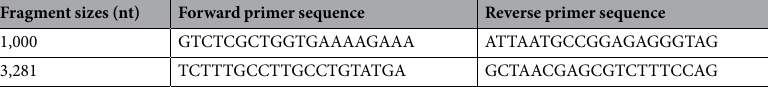
Polymerase enzyme characterization for ssDNA production. To evaluate reaction conditions for the synthesis of long ssDNA, two sets of validated aPCR primers and M13 genomic ssDNA as a template were used to generate products of sizes 1,000 nt and 3,281 nt (Table 1) 11 . The following enzymes were purchased from the respective commercial providers to test enzymatic produc- tion of ssDNA: AccuStart ™ , AccuStart ™ II, and AccuStart ™ HiFi from Quantabio; Q5 ® hot start HiFi, Phusion ® , LongAmp ® , Deep Vent ® , and Deep Vent ® (exo-) from New England BioLabs Inc. (NEB); AccuPrime ™ , Platinum ™ SuperFi ™ , Tth and DreamTaq ™ from ThermoFisher Scientific Inc.; GoTaq ® from Promega (Promega corp.); and LA Taq ® from Takara Bio. These were characterized for their aPCR efficiency, yield, and off-target production metrics for the quality of aPCR. Each enzyme was evaluated using the supplier’s recommended pro- tocol for traditional PCR, including supplied buffers (Supplementary Table S1), with the exception that the for- ward primer was used in 50-fold excess over the reverse primer. Annealing temperatures were evaluated at 55 °C and reactions were thermocycled 30 times. Products were run on a 0.7–1% low-melt agarose gel (IBI Scientific, Inc.) cast with ethidium bromide (Sigma Aldrich, Inc.) or SybrSafe (ThermoFisher Scientific, Inc.) at 90 V for 1–2 hours, depending on fragment size, and visualized under blue or UV light illumination. Equal reaction vol- umes were used in each lane. Band intensities were analyzed with ImageJ Gel Analyzer 31,32 for comparison. Reagent evaluation. Systematic evaluation of the aPCR reaction included characterizing the impact of magnesium concentration, bottom-strand concentration, template concentration, cycle number, and annealing temperature. For AccuStart HiFi reactions, the standard aPCR reaction was set using 1x AccuStart HiFi buffer (60 mM Tris-SO double stranded gBlock from Integrated DNA Technologies, Gibson assembled dsDNA 33 , or Phusion generated and purified double stranded DNA template), brought to 50 µ L with nuclease-free water (IDT), with 0.22 µ L AccuStart HiFi enzyme added to begin synthesis. Thermocycled reactions were initiated for 1 min at 94 °C, and thereafter cycled 30 times for 20 s at 94 °C, 30 s at 55 °C, and 90 s per kilobase at 68 °C. Variations in cycling param- eters were performed about this reaction, with 20 µ L reactions combined with 4 µ L 6x loading buffer ran on 1% low-melt agarose cast with 1x SybrSafe and ran for 1 hour at 90 V. Gels were visualized with a blue-light illumina- tion and band intensities were quantitated by integration using ImageJ 31,32 . LongAmp reactions were similar in setup to the AccuStart HiFi. The standard reaction was in 1x LongAmp buffer (60 mM Tris-SO phage genomic DNA) and 2 µ L LongAmp Taq DNA polymerase mix and brought to 50 µ L. Thermocycled reac- tions were initiated for 30 s at 94 °C and cycled 30 times for 20 s at 94 °C, 45 s at 56.5 °C, and 90 s per kilobase at 65 °C. Parameter optimization was carried out by varying this general reaction. Samples were run on a 0.8% low-melt agarose gel stained with either ethidium bromide or SybrSafe for 1–1.5 hours at 100 V. Gels were visual- ized with UV or blue light and band densities were quantified by integration with ImageJ 31,32 . Titrations of reaction component concentrations including magnesium, template, and reverse primer concen- trations, and varying the number of cycles were carried out for both HiFi and LongAmp reactions for 1,000 nt and 3,281 nt ssDNA products. Reaction conditions and associated band intensities are presented in External Table 1. Purified ssDNA quantitated by UV absorbance at 260 nm wavelength was titrated on an agarose gel, and band intensities were measured using ImageJ to generate a standard intensity curve, which was then used to quantitate ssDNA production from a triplicate of aPCR reactions. ssDNA purification. volumes) of the provided binding buffer were added to the excised gel, and left to melt in an incubator at 45 °C for 10 min. The melted agarose gel solution was transferred to the silica-based spin columns and mounted on a col- lection tube, and centrifuged for 60 s at 11,000 RPM. After discarding the flow-through, 250 µ L of ethanol-based DNA wash buffer were used to wash the column twice by centrifuging for 60 s at 11,000 RPM and discarding the flow-through each time. The ssDNA was recovered with 6–15 µ L of elution buffer, after centrifugation for 60 s at 11,000 RPM. The concentration of recovered ssDNA was measured using a NanoDrop ™ 2000 UV-Vis Spectrophotometer (Thermo Fisher Scientific Inc.). Final purified ssDNA was verified by Sanger sequencing from the 3 ′ end. Modified dNTPs incorporated into long ssDNA.